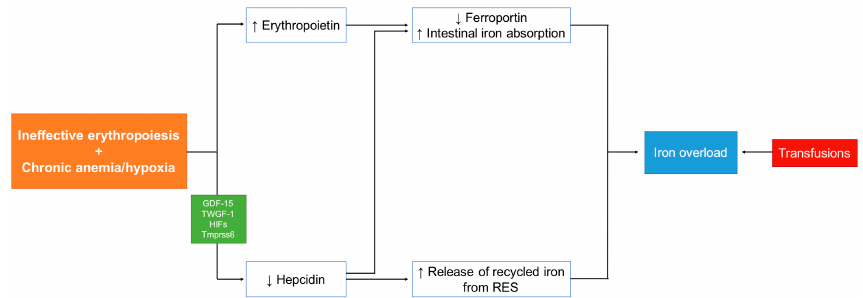
Figure 1. Iron overload mechanism in non-transfusion-dependent thalassemia. GDF-15: growth differentiation factor-15; TWGF-1: twisted gastrulation factor-1; HIFs: hypoxia inducible transcription factors; TMPRSS6: transmembrane protease, serine 6. ( ↑ : increase; ↓ : decrease).